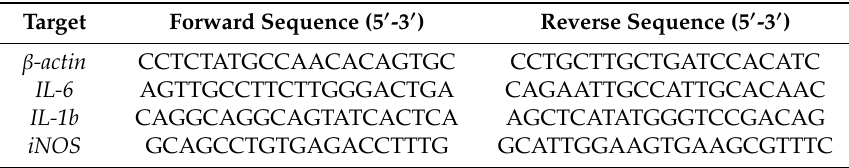
Table 1. Primer sequence information of target